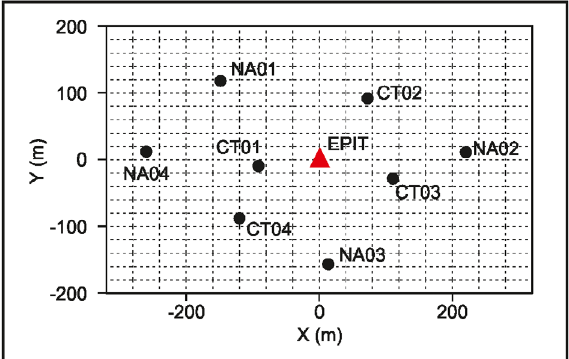
Figure 2. Configuration of the seismic array deployed in 2014 around Pozzo Pitarrone (red triangle).